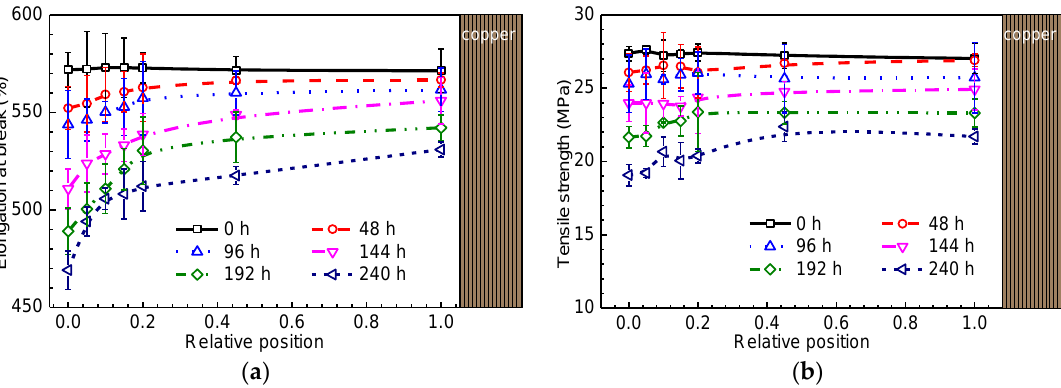
Figure 5. ( a ) Profile of elongation at break for different XLPE samples; ( b ) profile of tensile strength for different XLPE samples.